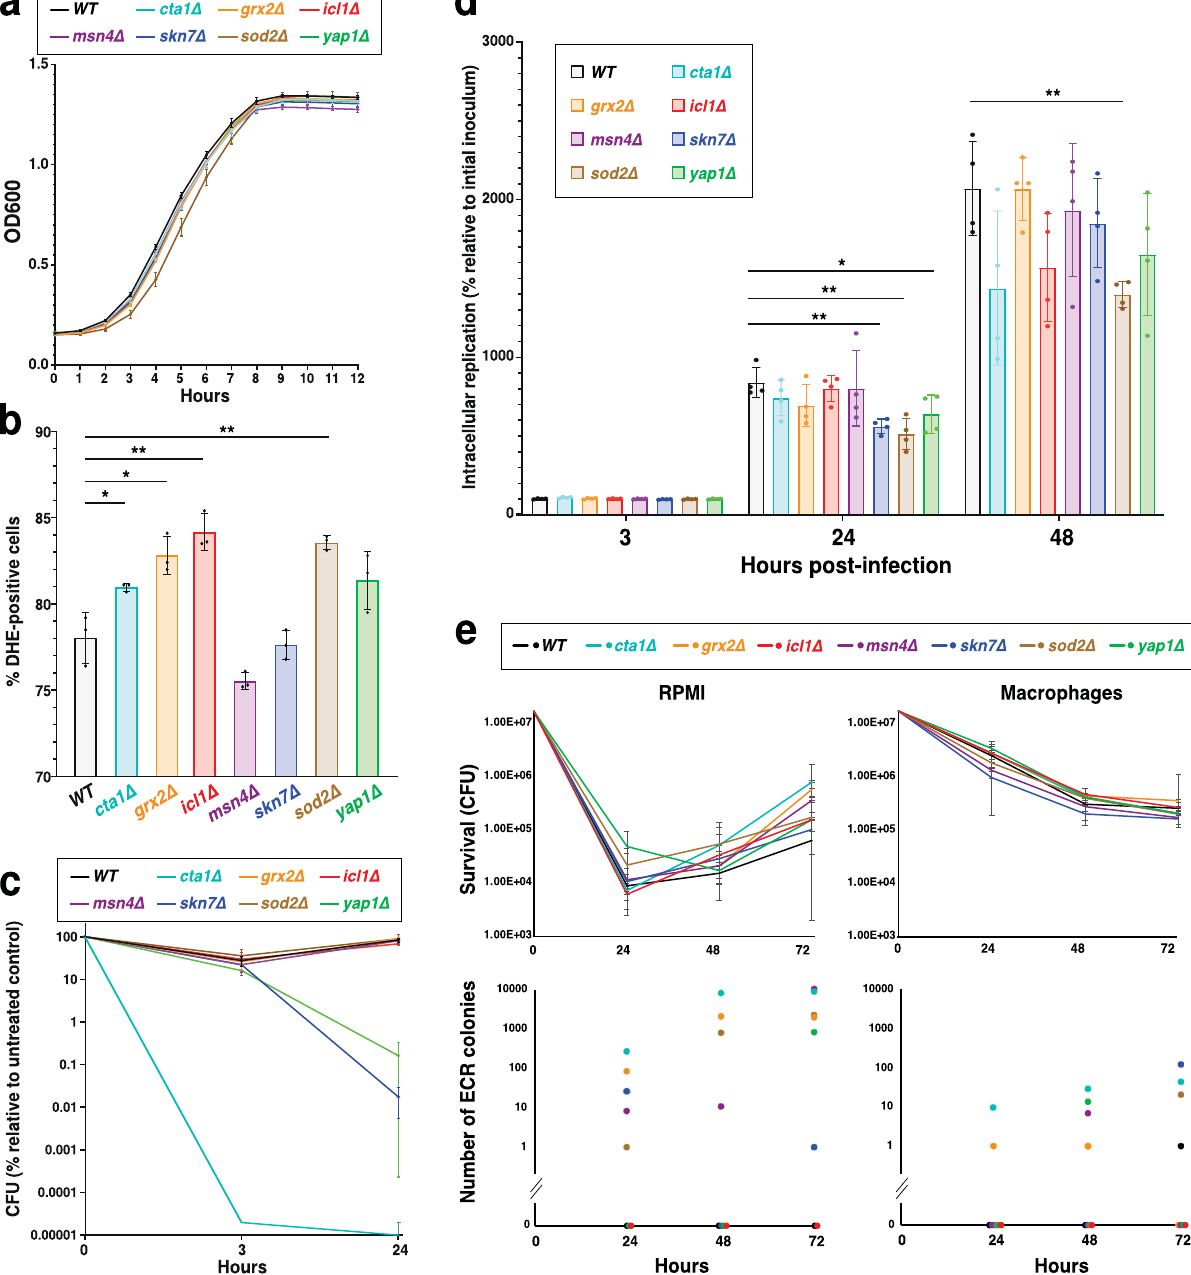
Fig. 5 | Deletion of C. glabrata ROS detoxi fi cation genes promotes the emer- gence of ECR mutants in both ICG and planktonic cells. a ROS mutants had normalgrowthratesinYPDbroth. n =3biologicalreplicatesinasingleexperiment. b With the exception of msn4 Δ and skn7 Δ , the ROS detoxi fi cation mutants had signi fi cantly higher superoxide levelscompared to the WT strain when exposedto micafungin (0.125 µ g/ml), as measured by DHE straining intensity. n =3 biological replicatesover3independentexperiments(* p <0.03,** p <0.003,two-sidedpaired t-test). c In the presence of 10mM H 2 O 2 cta1 Δ , skn7 Δ , and yap1 Δ mutants had signi fi cantly reduced survival compared to the WT strain. n =4 biological replicates over two independent experiments. d Several ROS mutants had mild